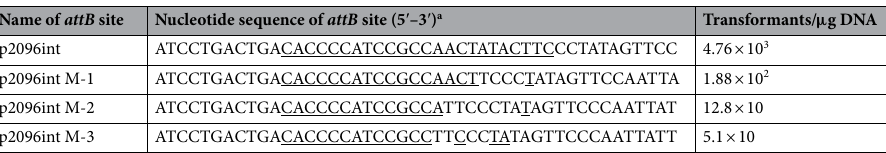
Table 3. Transformation efficiency with p2096int vector retaining truncated attB site. a Nucleotide sequences of attB were shown by